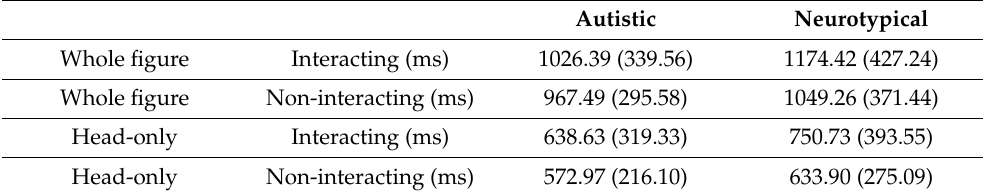
Table 2. Details of dwell time data in milliseconds (ms) for the two groups. Scores show the mean, with standard deviation in brackets.